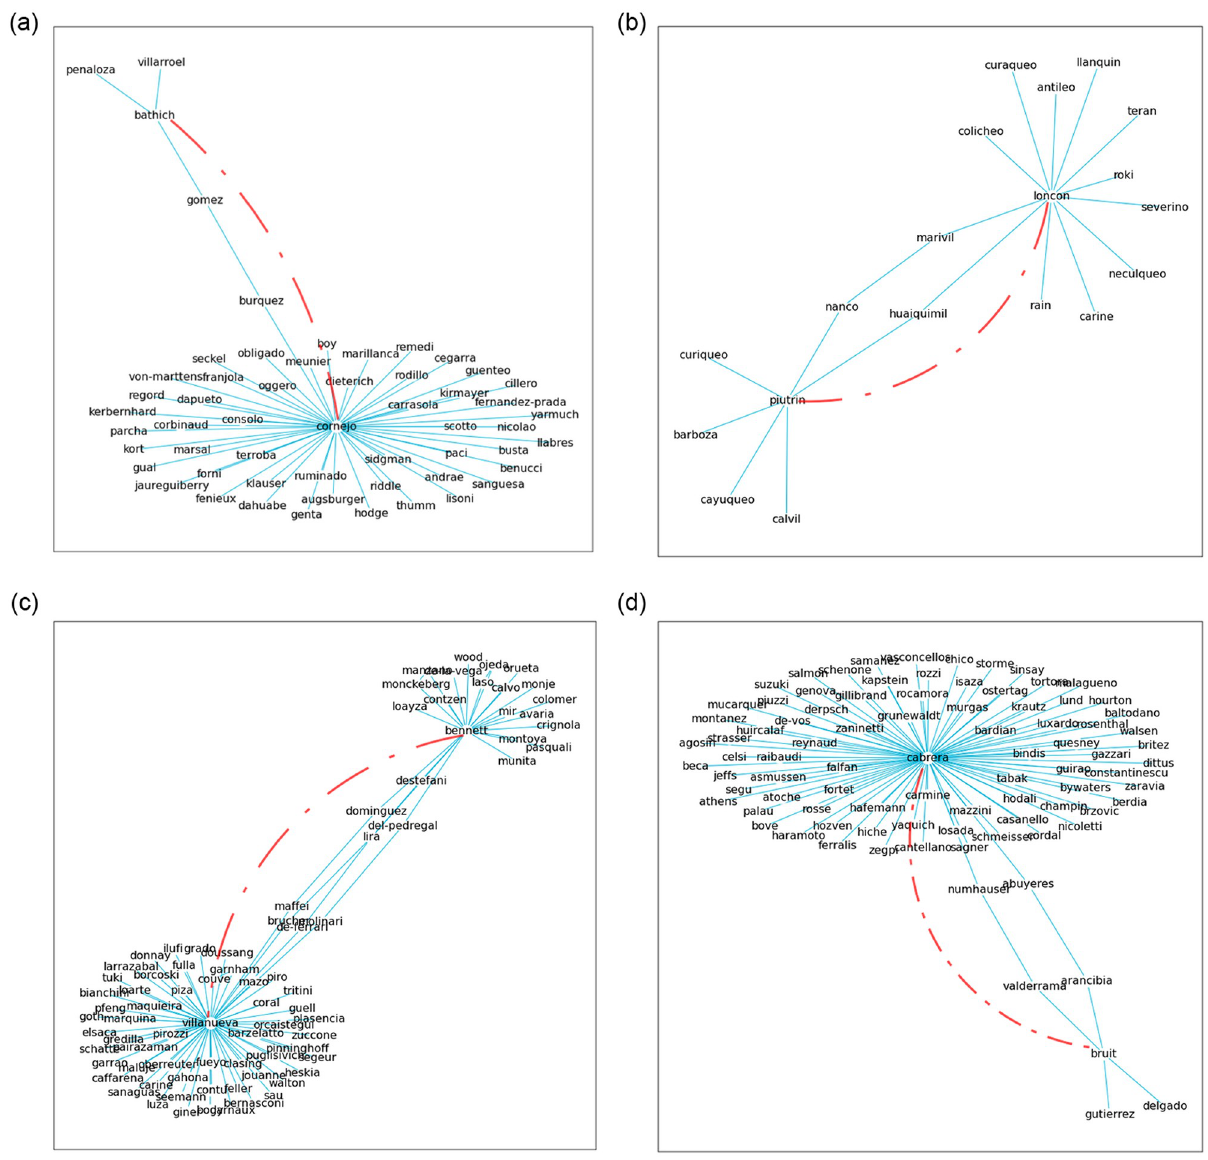
Fig 7. Grounded predictions generally show paths that connect two micro-clusters. Figures a and d show the connection of a larger cluster and a smaller one, exhibiting an absorption pattern. Figures b and c show the relationship of two clusters of similar sizes. In all the cases indicated, the new connection (marked with a red dotted line) creates a shorter path between both micro-clusters, decreasing the resulting graph’s